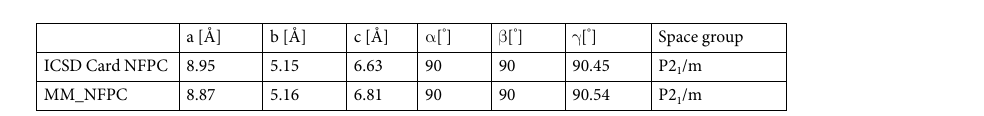
Table 1. The lattice parameters for the ICSD card and the MM_NFPC